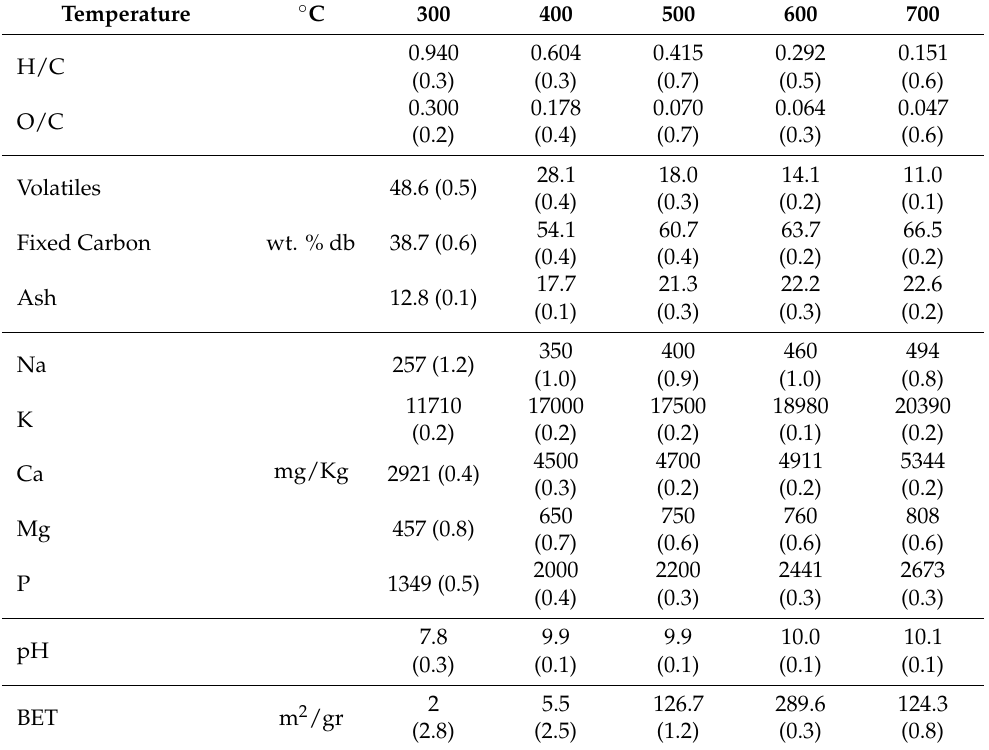
Table 4. Composition and properties of char of lignin-rich residue (LRR) obtained at different final temperatures. Percentage error is reported in